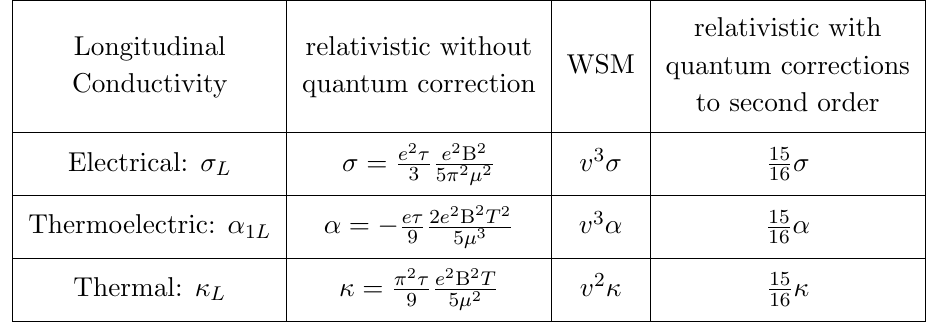
Table 1 . Longitudinal conductivities in the presence of magnetic field in the limit µ Fermi velocity in the unit of the light velocity. We are working in the relativistic system of units with ~ = c =